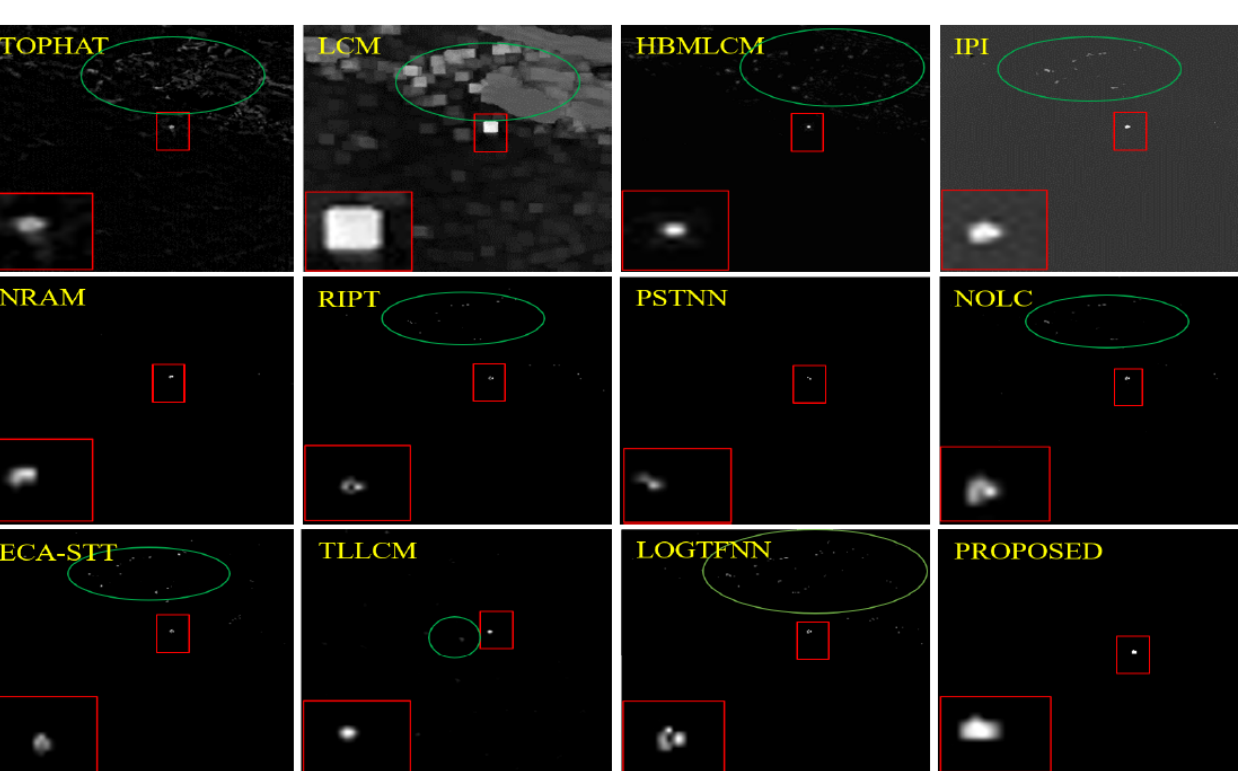
Figure 22. The detection results of data 1.